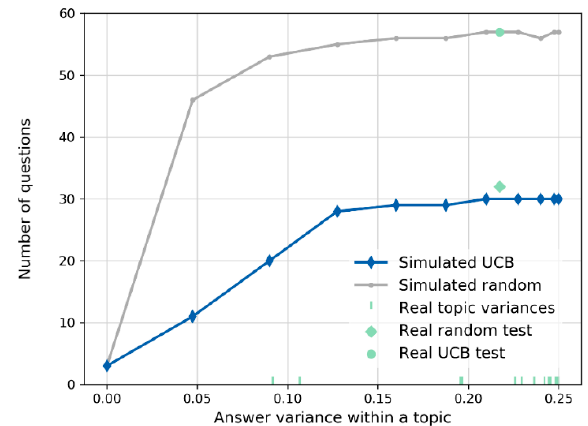
Figure 4. The impact of answer variance within topics on testing accuracy (number of questions needed to achieve 95% accuracy in a 60 question 15 topic quiz). The green markers indicate variance calculated using data from real tests, square and circle position along x axis represents average variance.